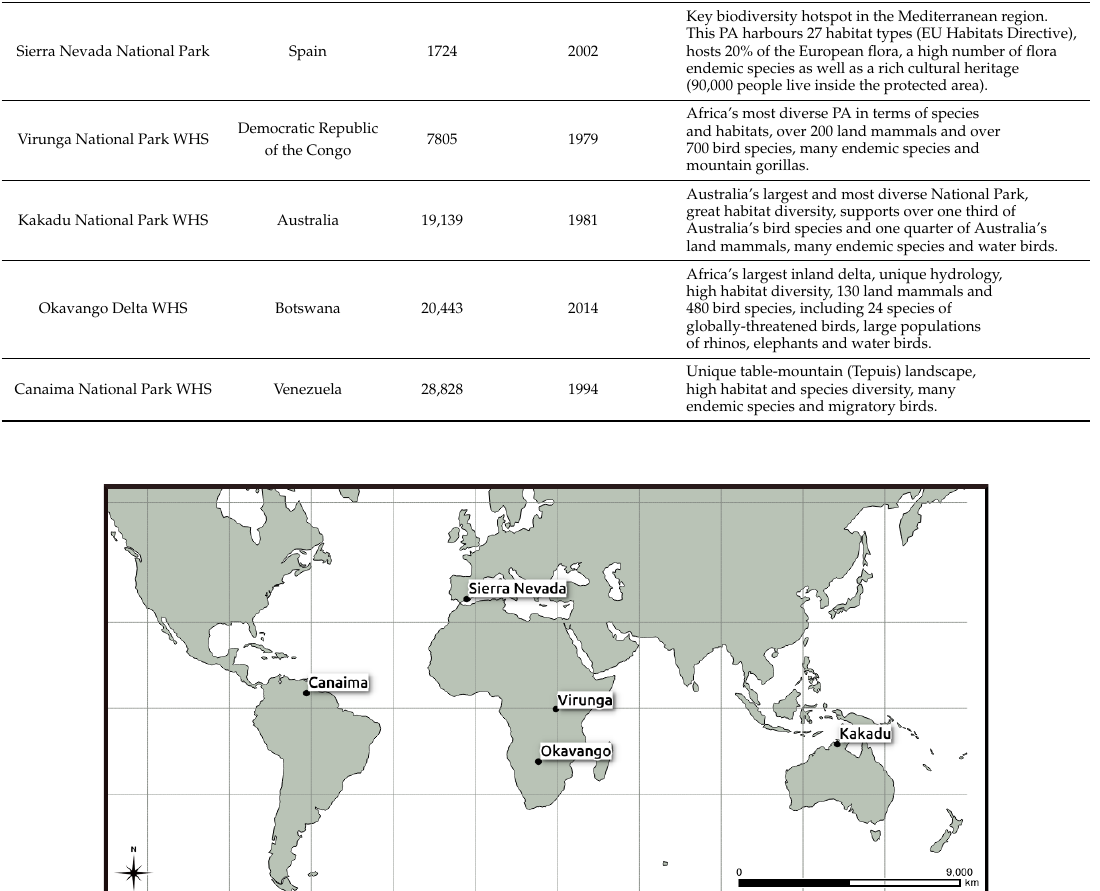
Key Biodiversity Values Key biodiversity hotspot in the Mediterranean region. This PA harbours 27 habitat types (EU Habitats Directive), hosts 20% of the European flora, a high number of flora endemic species as well as a rich cultural heritage (90,000 people live inside the protected area). 700 bird species, many endemic species and mountain gorillas.